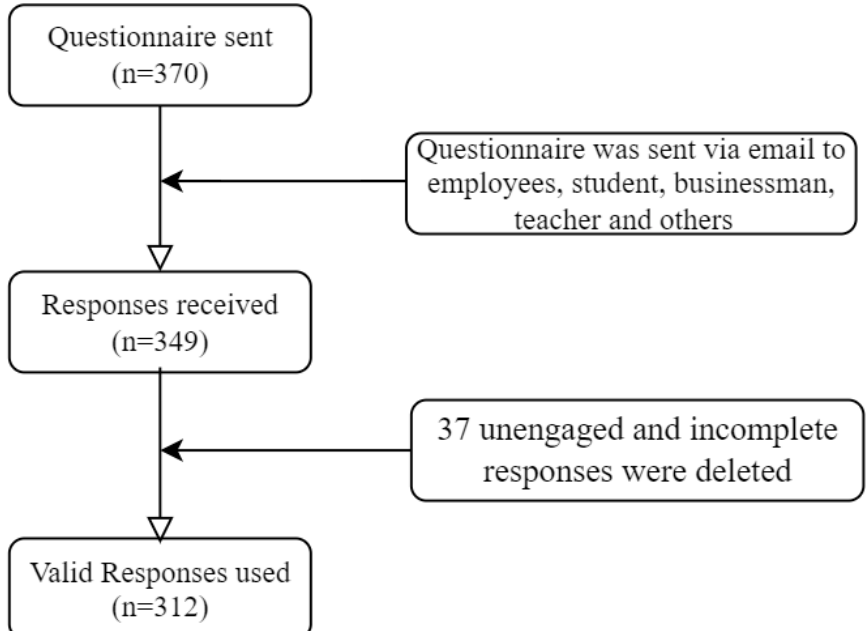
Figure 2. Participants’ inclusion flowchart.